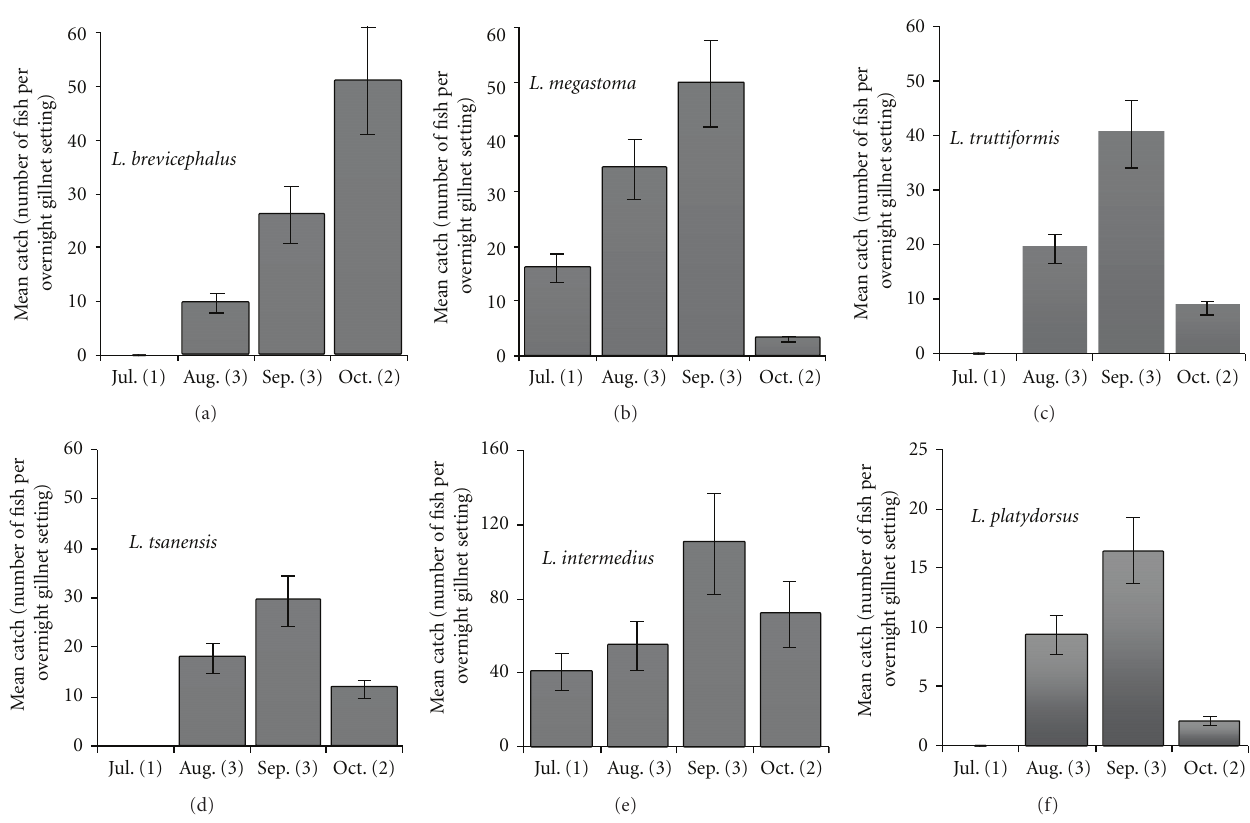
Figure 7: Mean abundance (number of fish per overnight gillnet setting) with 95% confidence limits (CL) of the six Labeobarbus species aggregating at Ribb River mouth during the spawning months (July to